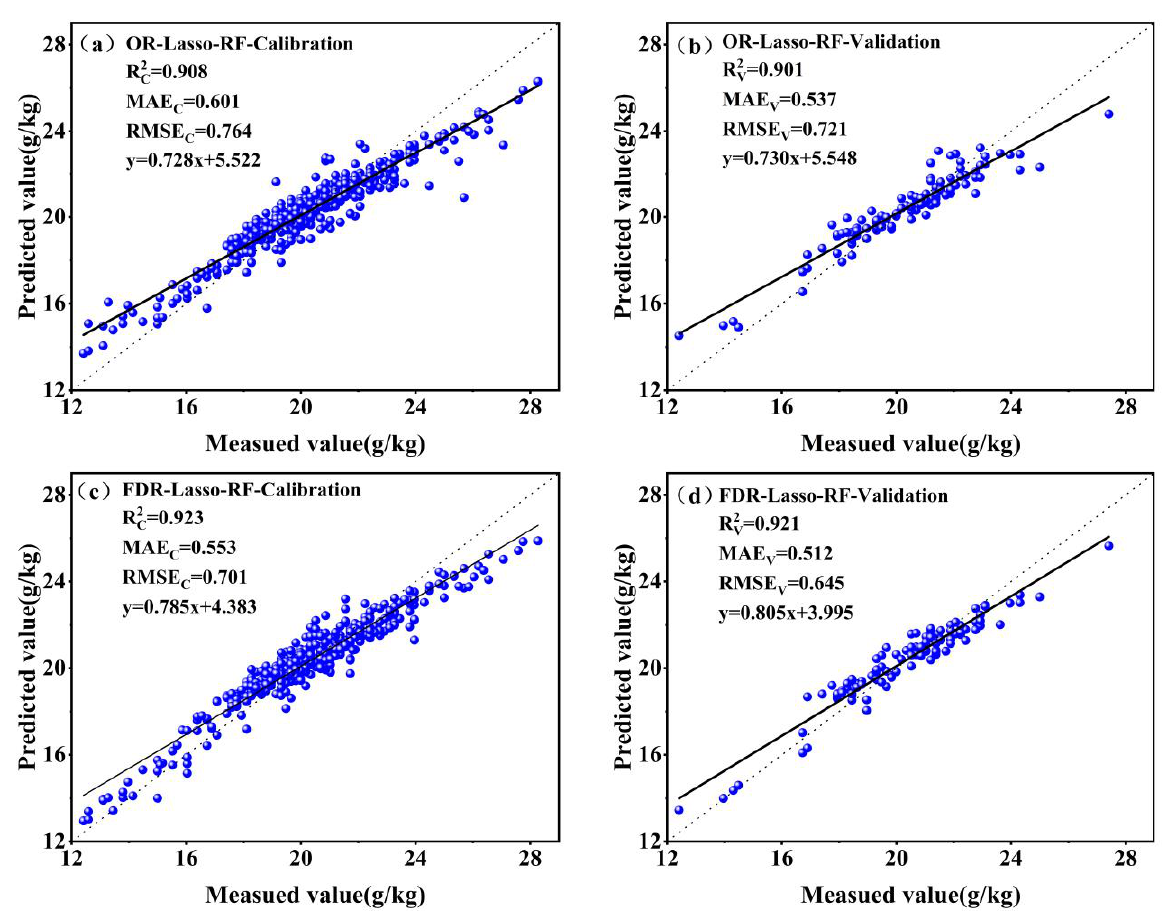
Figure 8. Scatter plot of predicted and measured SOM values for the Lasso signature band RF model (( a ) OR-Lasso-RF-Calibration; ( b ) OR-Lasso-RF-Validation; ( c ) FDR-Lasso-RF-Calibration; ( d ) FDR-Lasso-RF-Validation).